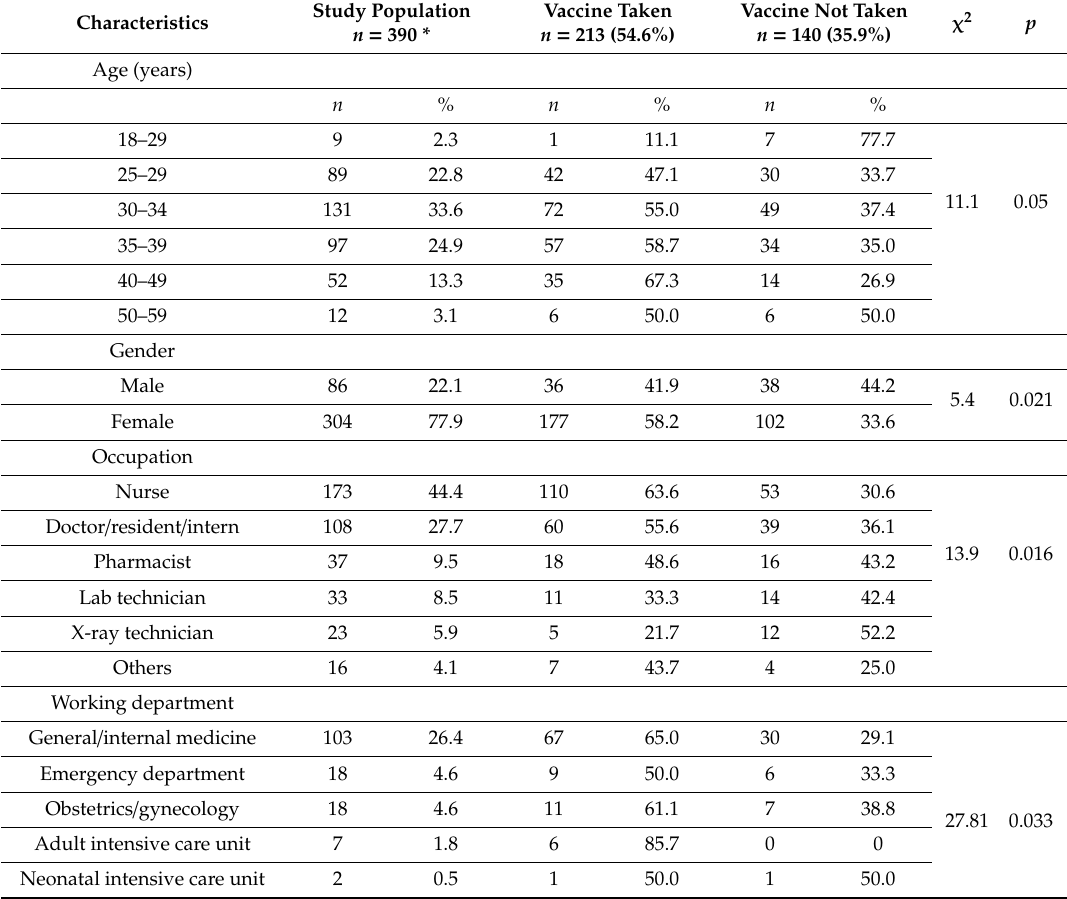
Table 1. Frequency table of demographic characteristics of the health care workers categorized by vaccination